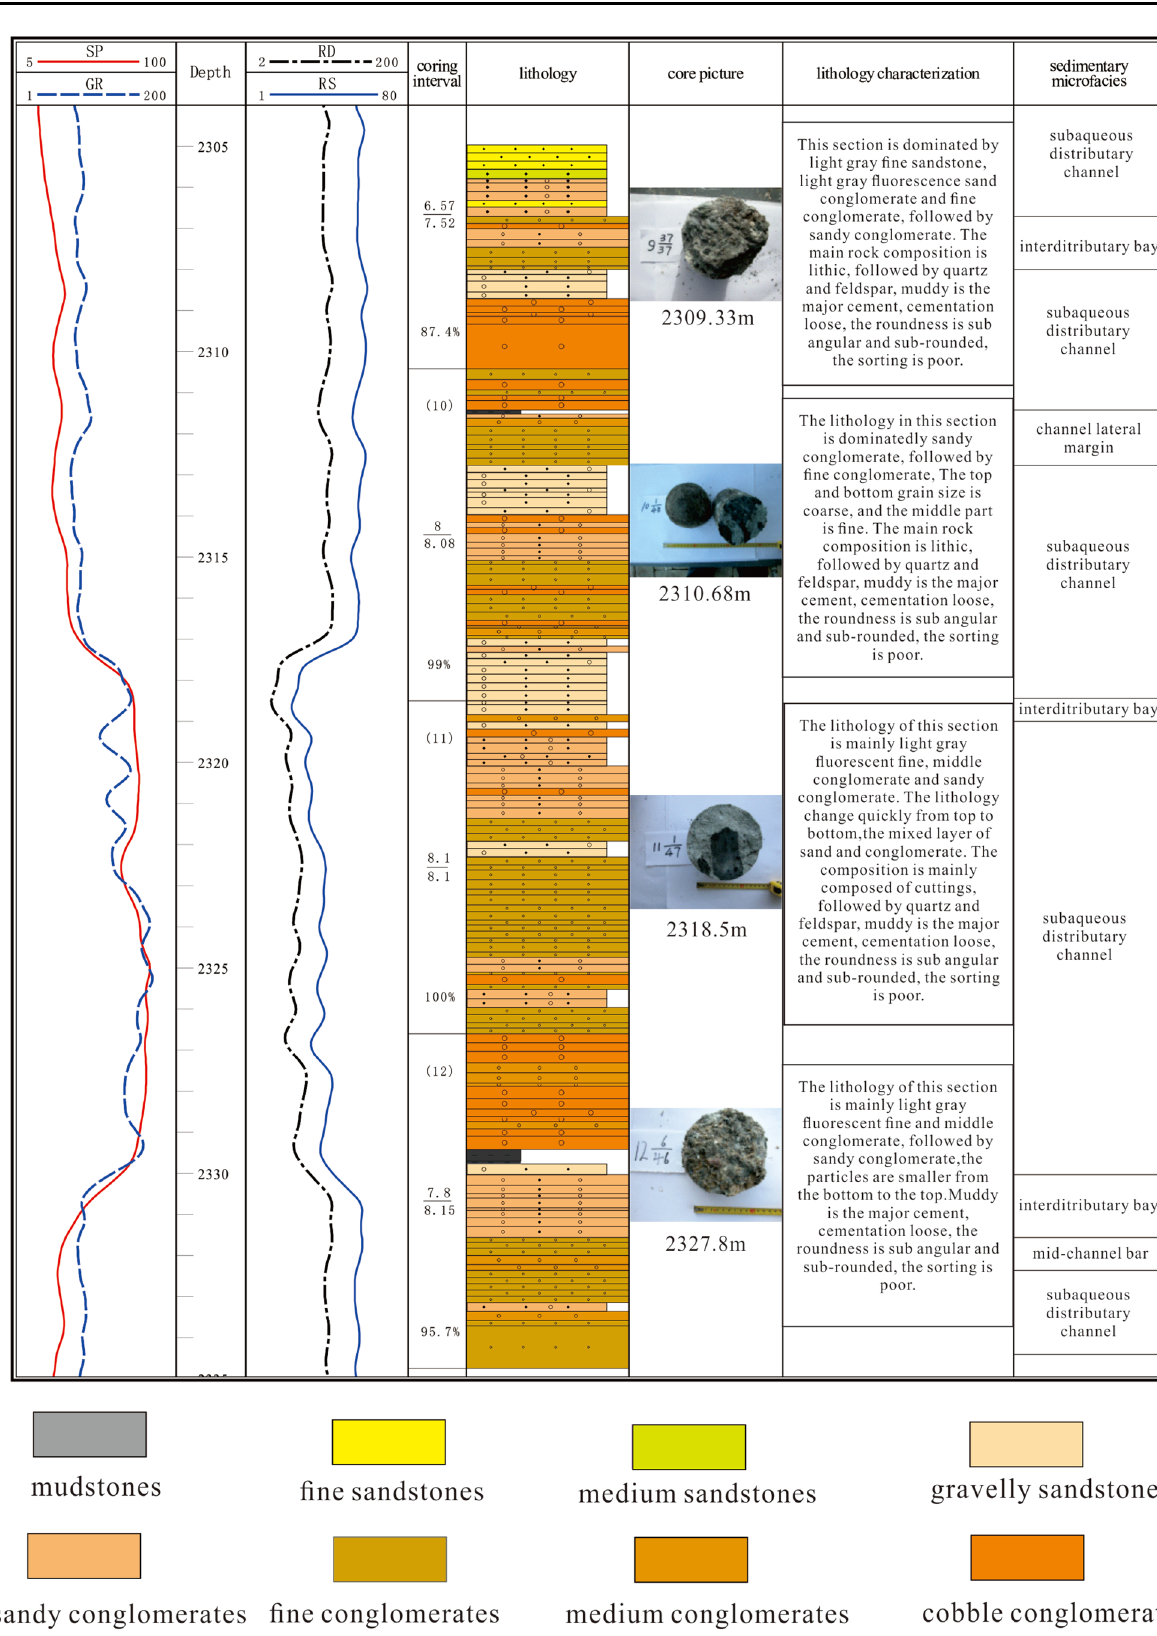
Fig. 5 Synthesis columnar section of core sedimentary petrofacies of well Bao